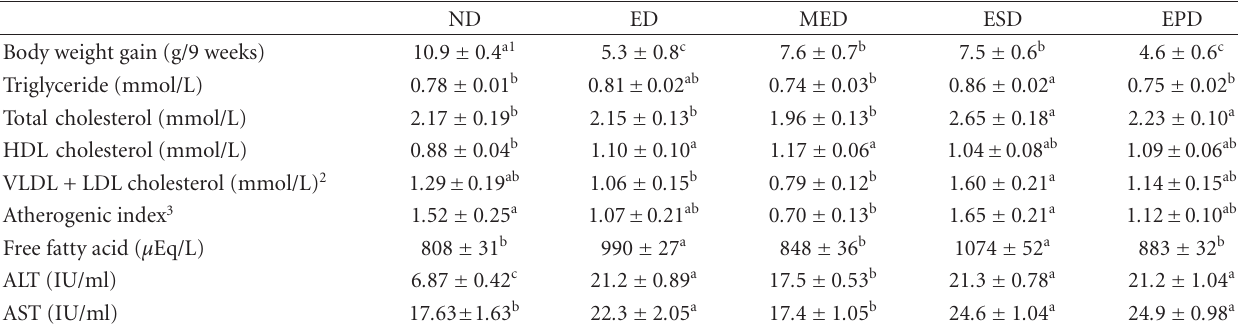
Table 2: Body weight gain and serum biochemistries of mice fed experimental